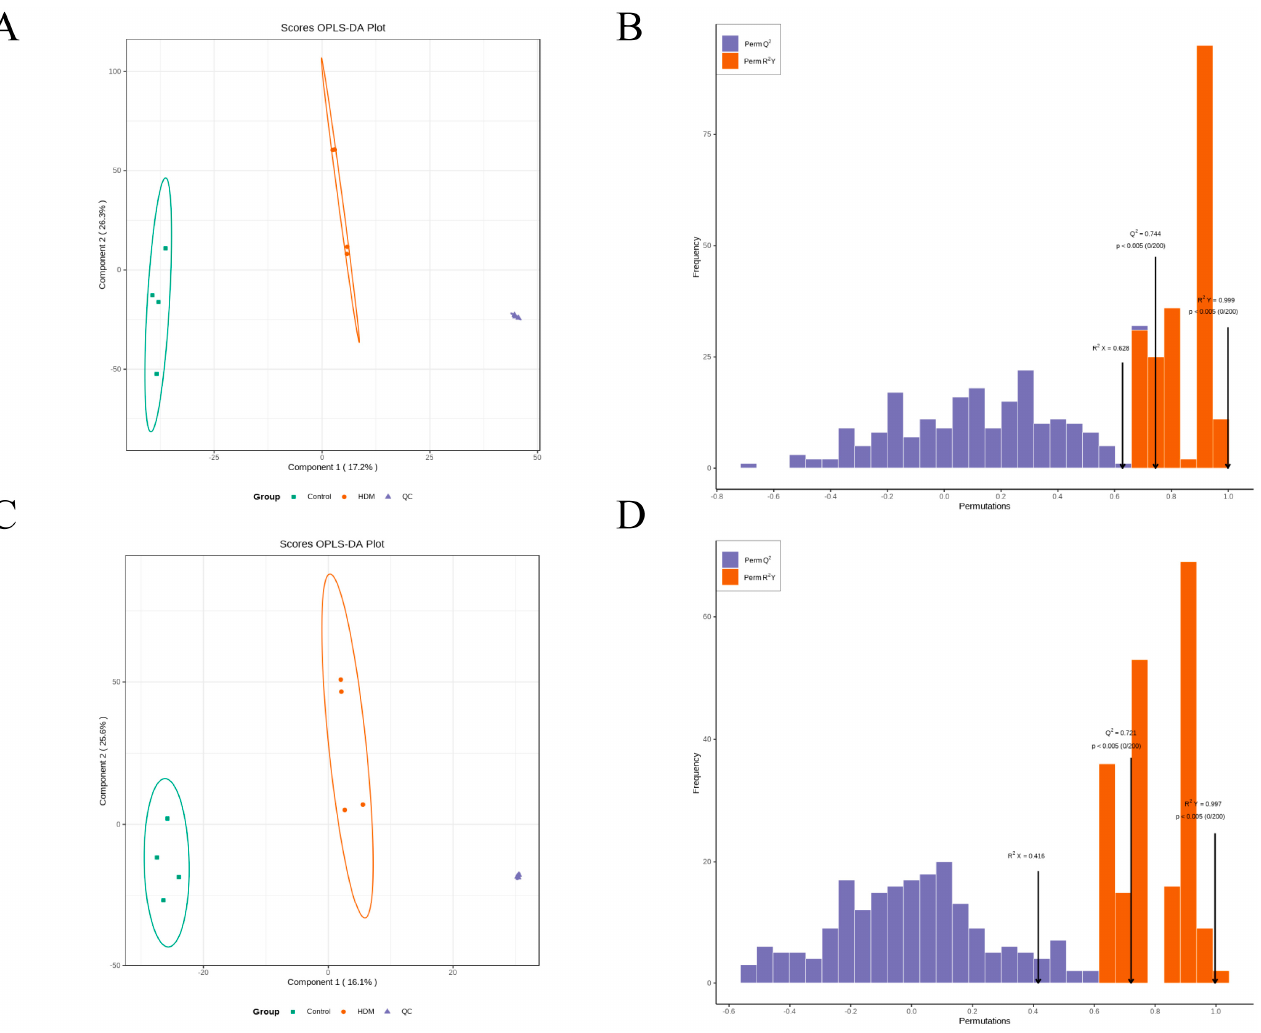
Figure 7. OPLS-DA score plots and permutation tests results. ( A , B ) OPLS-DA score plot and permutation tests result of metabolomics profiling in ESI+ mode. ( C , D ) OPLS-DA score plot and permutation tests result of metabolomics profiling in ESI −